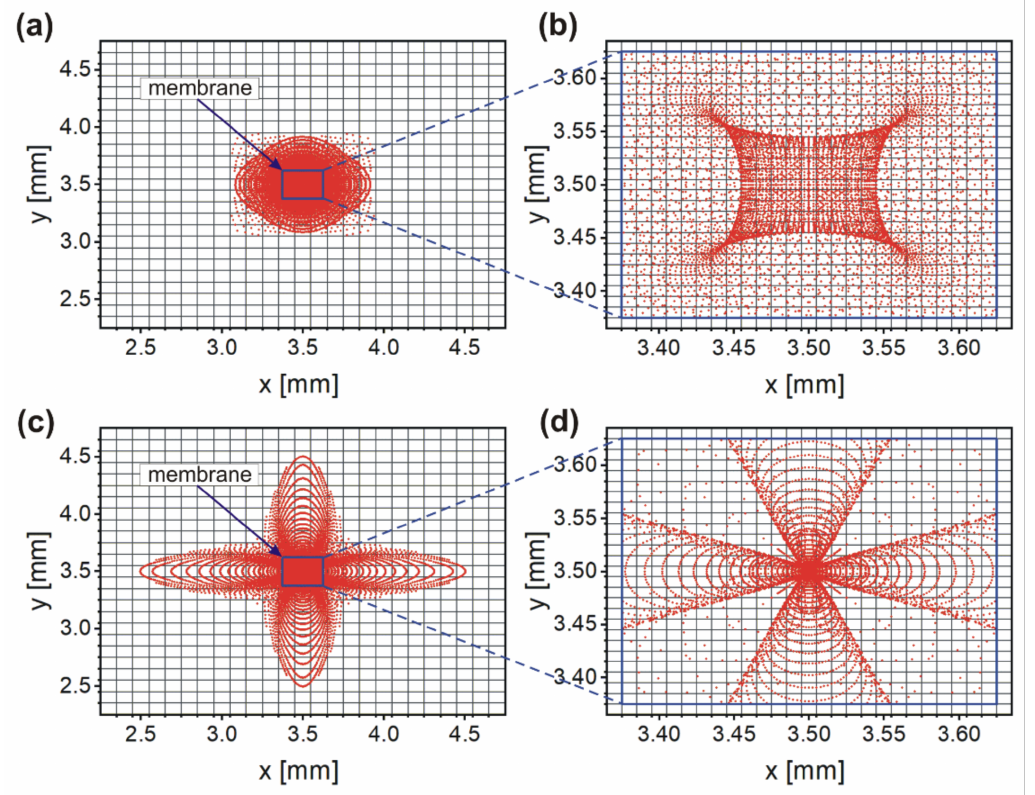
Figure 3. Electron beam coordinates recorded for 1 mm Einzel lens for: ( a ) U F = − 1700 V—anode; ( b ) U F = − 1700 V—membrane; ( c ) U F = − 1840 V—anode; ( d ) U F = − 1860 V—membrane. The surface of the anode was divided into small squares with an edge of 0.1 mm (Figure 3a,c, dark grey lines). Then, from the electron coordinates on the anode, the electron count was made in every square, which translates to a matrix of 49 × 49 that illustrates the electron intensity on the surface of the anode with a resolution of 0.1 mm. Using those matrices for every voltage, 3D plots and heat maps were made to observe the formation of the electron beam peak at the anode (Figure